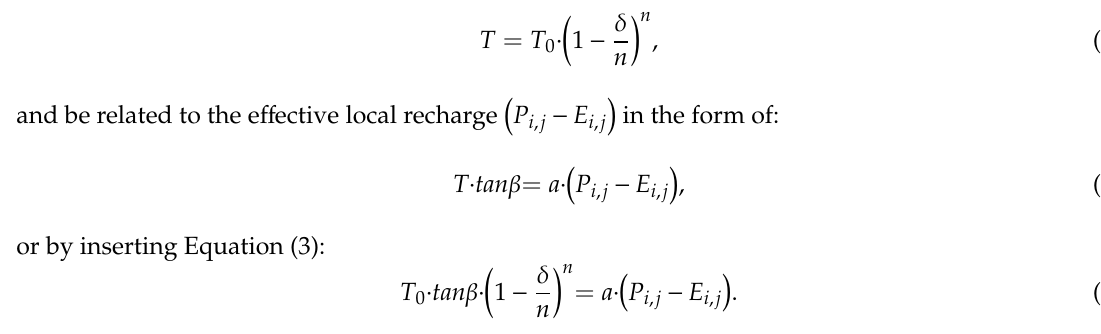
Bayesian statistical bias correction of satellite data based on in situ observation. The calibration and validation of coarse-resolution satellite water cycle products at selected field sites with in situ observation is an integral part of this procedure (at the kilometer scale but corrected for spatio-temporal error, e.g., due to topography, soil texture, and climate, cf. those by [19] for precipitation; [26] for evapotranspiration; and [8] for soil moisture); Development of downscaling methods based on Copernicus Sentinel data (from kilometer to hectometer scale). This procedure concerns evapotranspiration and soil moisture (by assuming the precipitation is homogeneous at the kilometer scale). Downscaling will be achieved by the combined use of optical, thermal, and radar data from Sentinel-1, 2, and